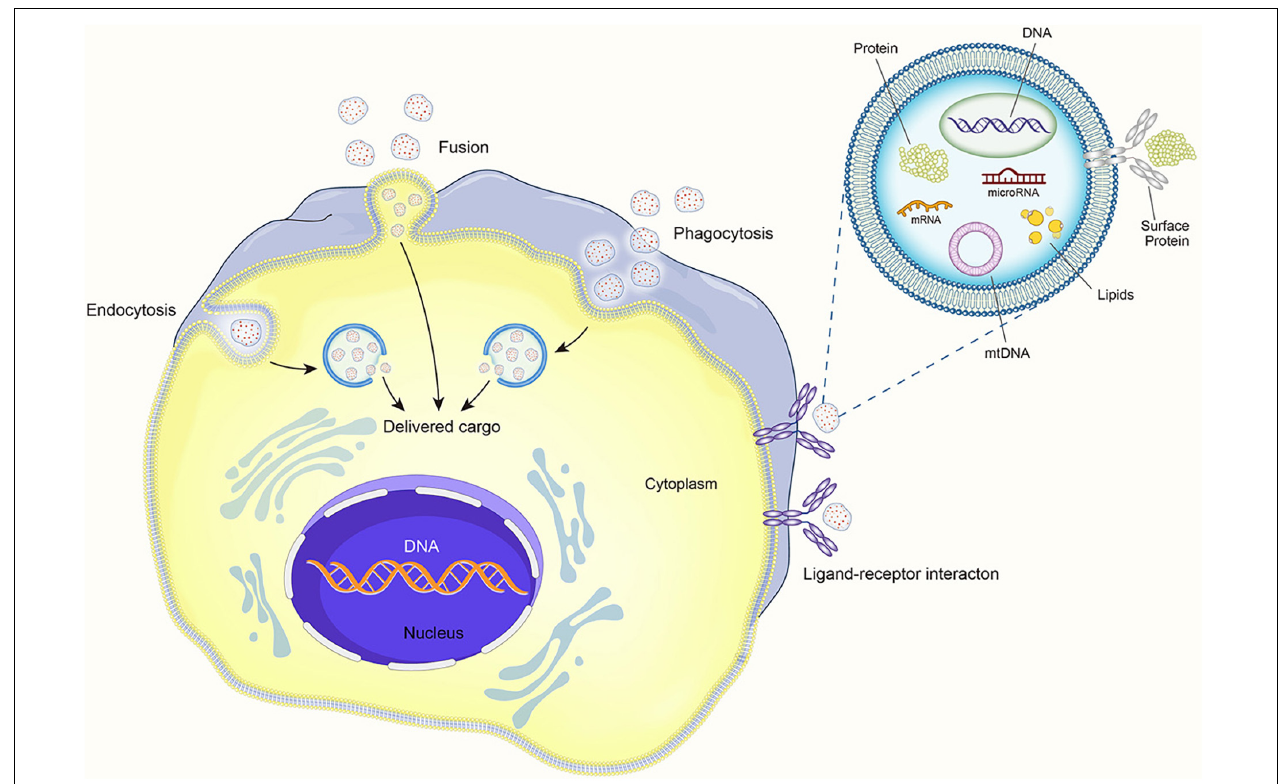
FIGURE 2 | The process of extracellular vesicles communicating with target